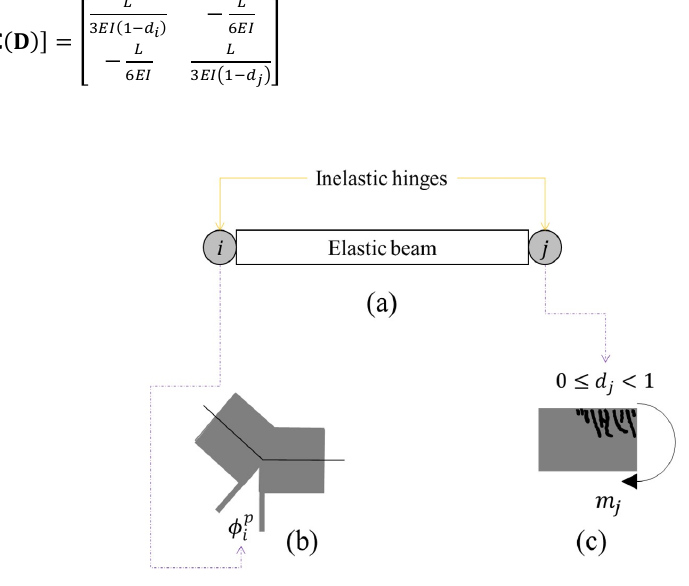
Figure 2. Lumped damage mechanics for RC beams: (a) elastic beam with inelastic hinges, (b) reinforcement yielding and (c) concrete